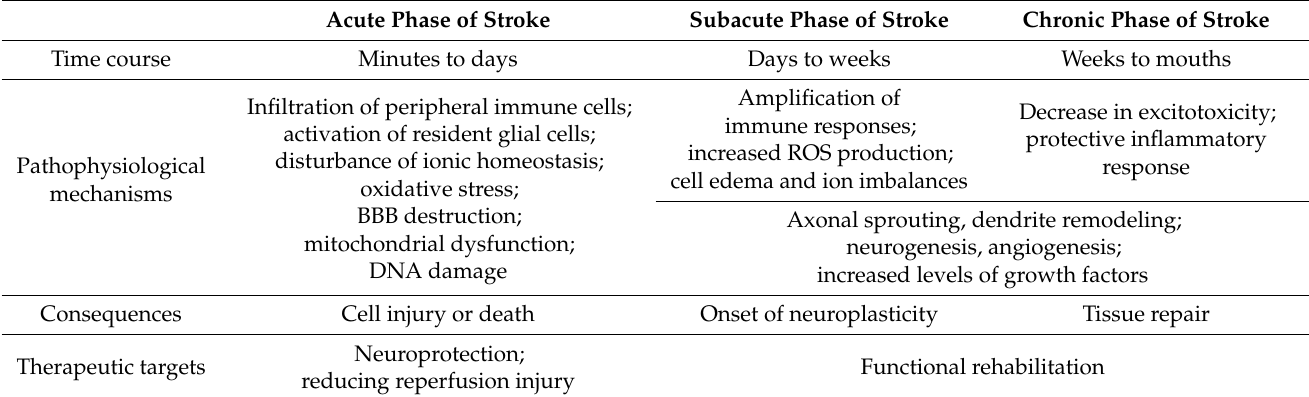
Table 1. Pathophysiology and therapeutic targets of ischemic stroke in the acute, subacute, and chronic phases. BBB, blood-brain barrier; ROS, reactive oxygen species. Acute Phase of